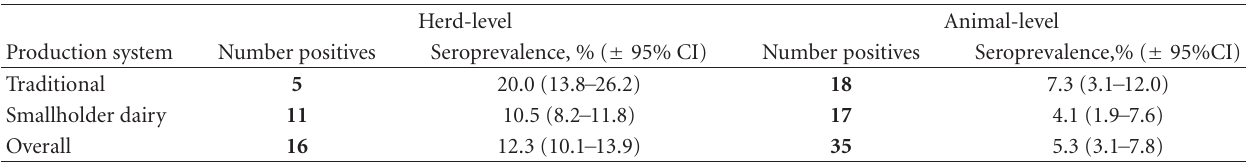
Table 2: The prevalence (with exact ± 95% confidence intervals) of animal and herd-level seropositivity for Brucella by production system